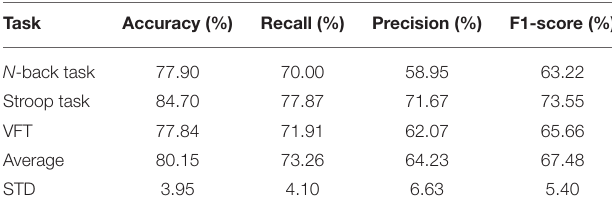
TABLE 5 | Convolutional neural network classification results of neuroimaging with spatial features for the Stroop task. Features